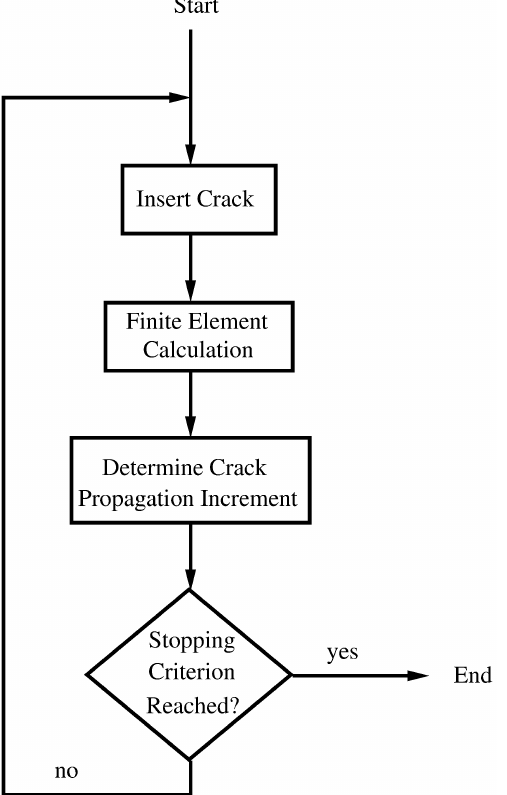
Figure 3. Scheme of CRACKTRACER3D.